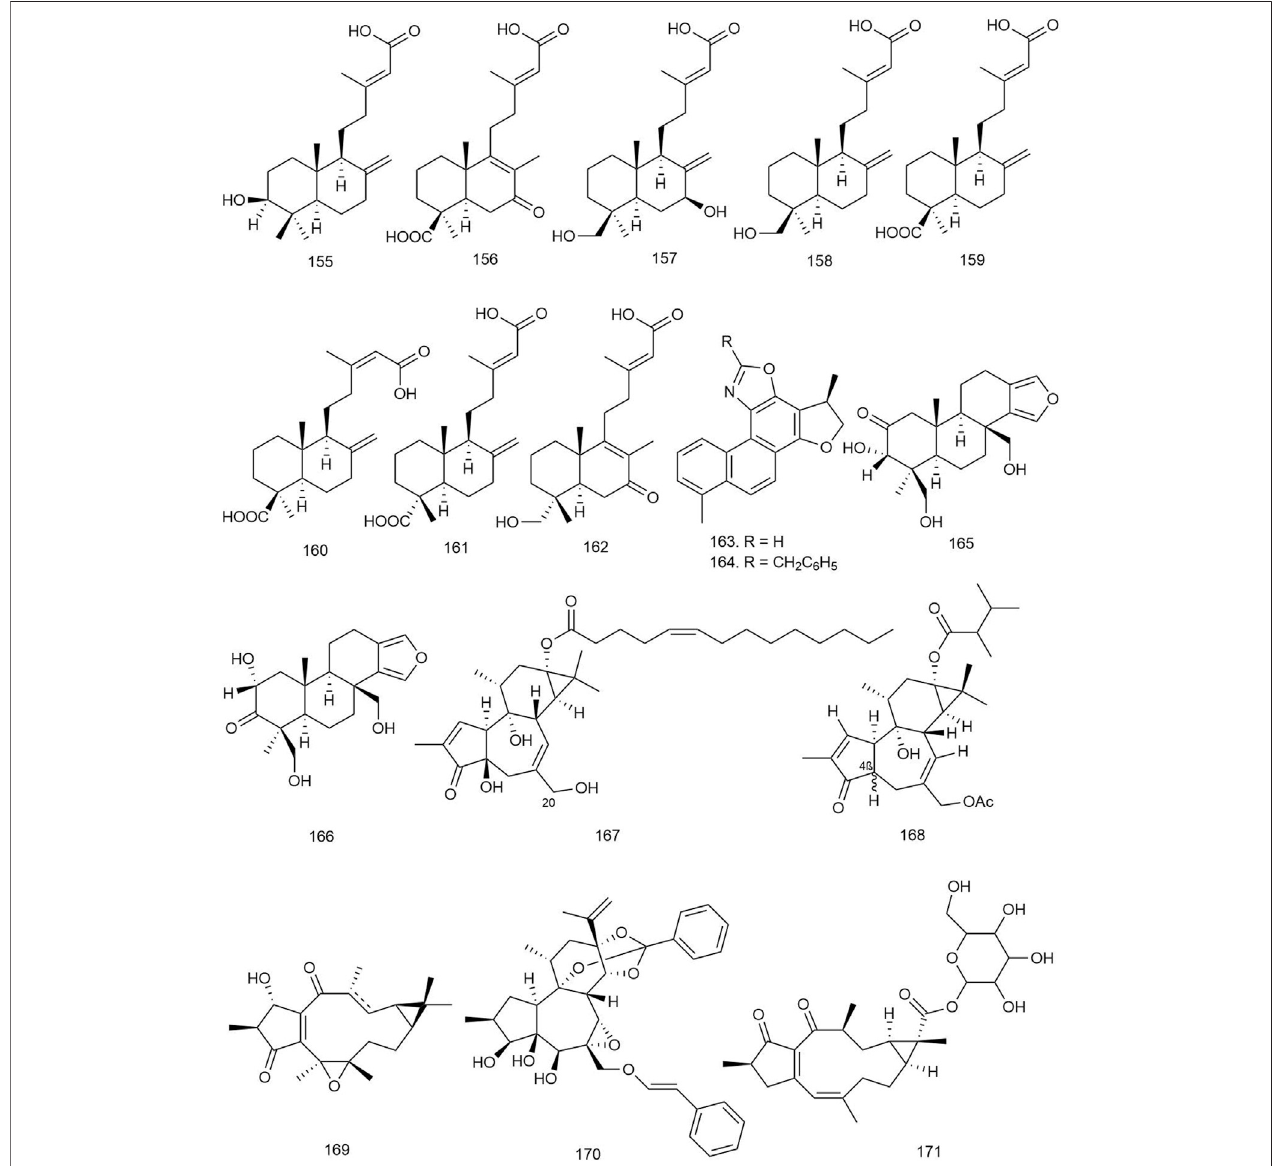
FIGURE9| Structuresofingenane,jatrophane,kauranoid,labdane,oxazole-containing,spongian,tigilane,andmiscellaneousditerpenoidswithsigni fi cantantiviralactivity.